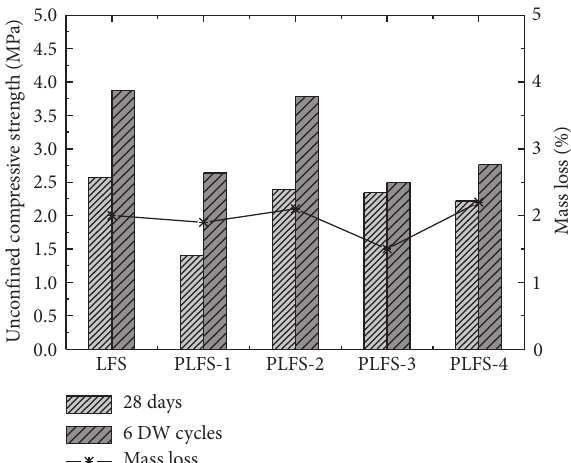
Figure 6: The influence of dry-wet cycles on unconfined compressive